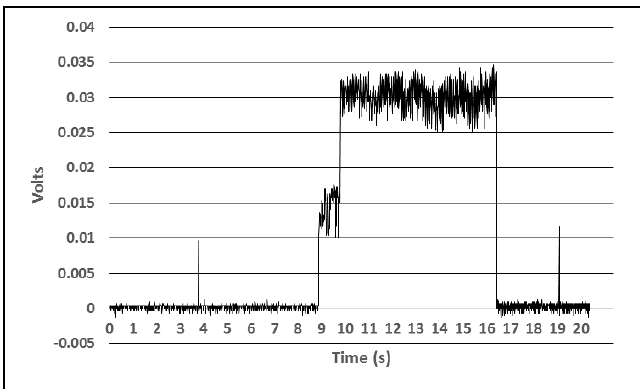
Figure 8. Consumption profile during advertizing and